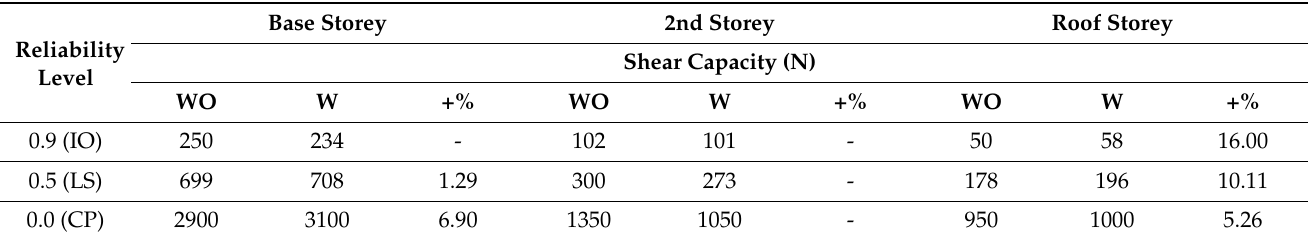
Table 5. Summary output of statistical analysis with (W) and without (WO) dampers